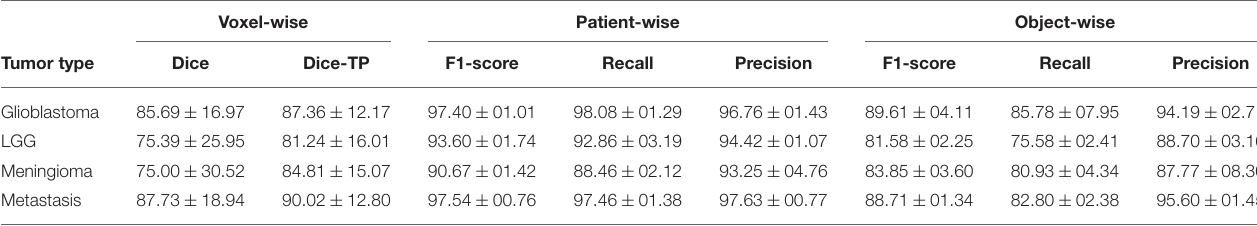
TABLE 3 | Segmentation performance summary for each tumor